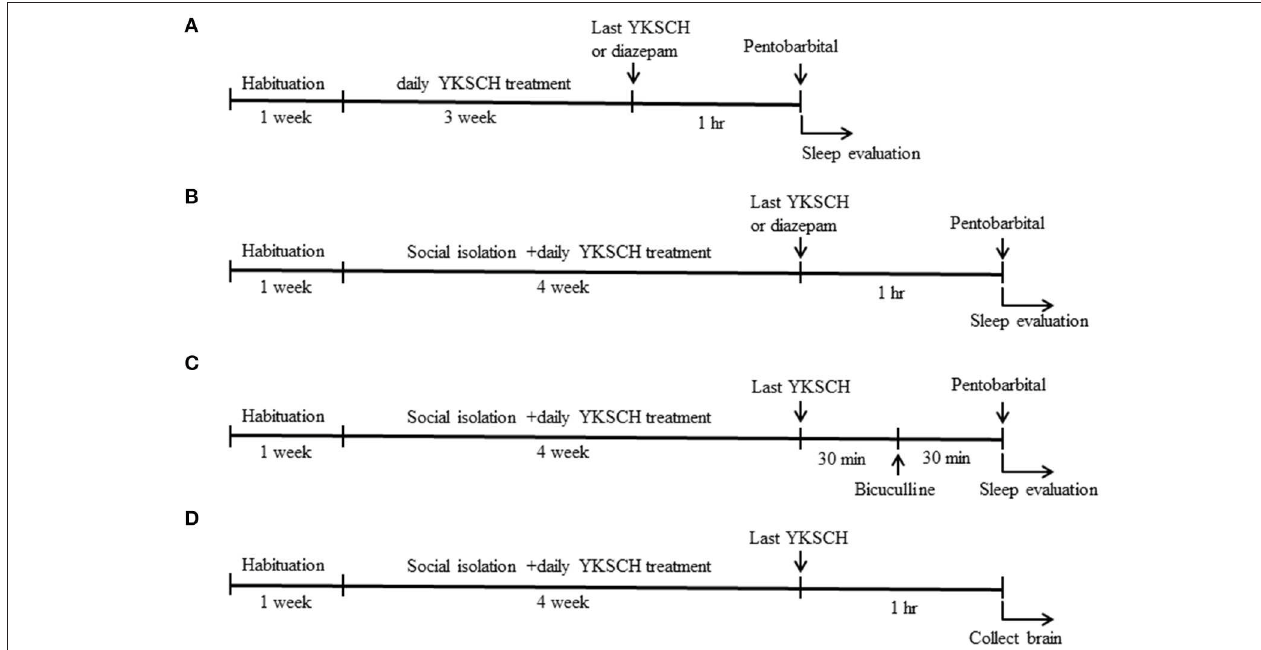
FIGURE 1 | Time schedule of the experiment. Six-week-old male ddy mice were used in this study. Mice were pretreated with 1,500 mg/kg YKSCH for 3 weeks in a group-housed mouse study (A) or for 4 weeks in a social isolation stress study (B) . One hour after the last treatment, mice were treated with 60 mg/kg pentobarbital. For the GABA receptor antagonist study, mice were treated with 3 mg/kg bicuculline 30min after the last YKSCH treatment in socially isolated mice (C) . For the ELISA and western blot analysis, socially isolated mice were treated with YKSCH for 4 weeks, and mice were sacrificed 1h after the last YKSCH treatment (D) .